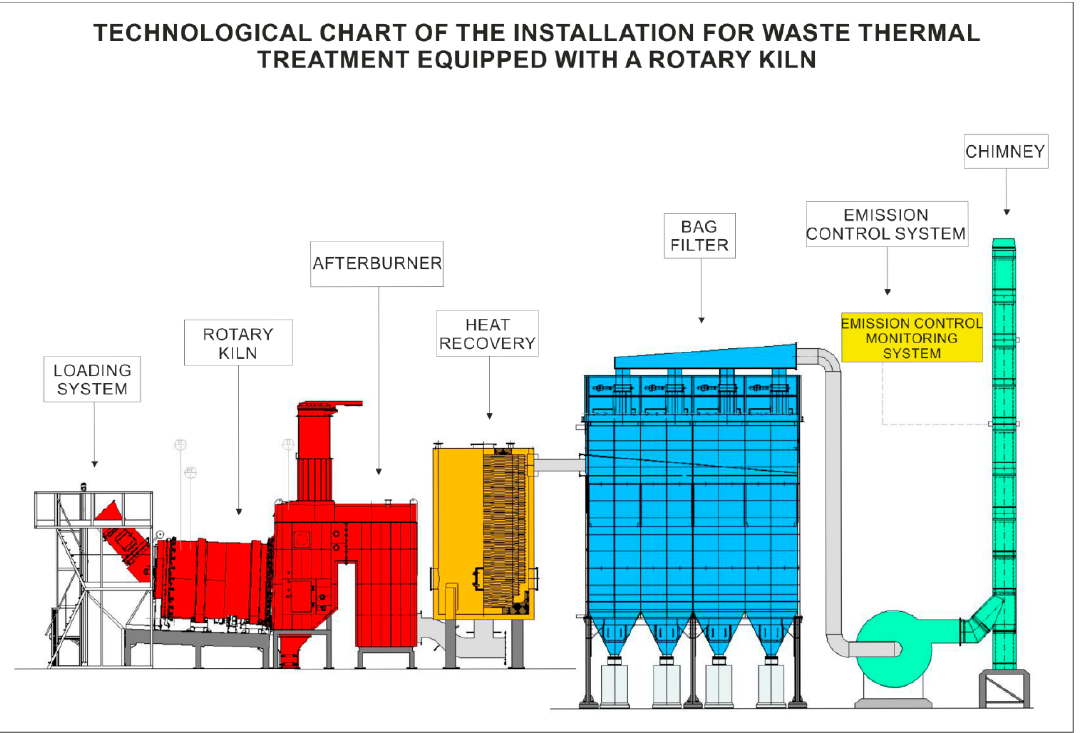
Figure 1. The waste incineration system with heat recovery.